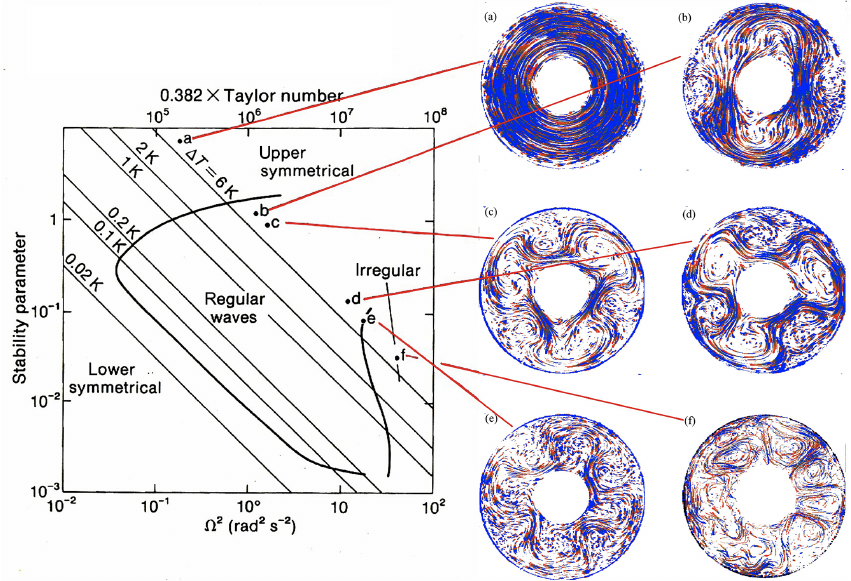
Figure 6. Regime diagram for the baroclinically stable and unstable flows in a thermally driven, rotating annulus as a function of the thermal Rossby number (shown here as “Stability parameter”) and Taylor number (e.g. Read et al., 2015), showing snapshots of typical equilibrated flows as visualised using neutrally buoyant tracer particles and side illumination to obtain streak